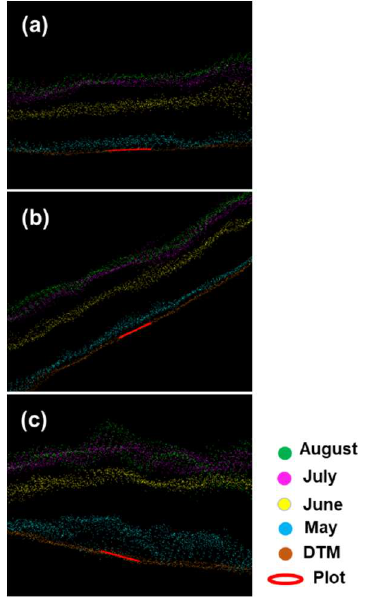
Figure 12. Point cloud of each month from May to August on top of the hill (a), slope (b) and sunken place (c) The proposed method to estimate biomass of M. sinensis worked well. June data has the best potential to predict biomass of M. sinensis in this area (Figure 8b). By topographic landforms, July data estimated biomass best for sunken place (Figure 9c), while June data did for top of the hill (Figure 11b). As for slope, R